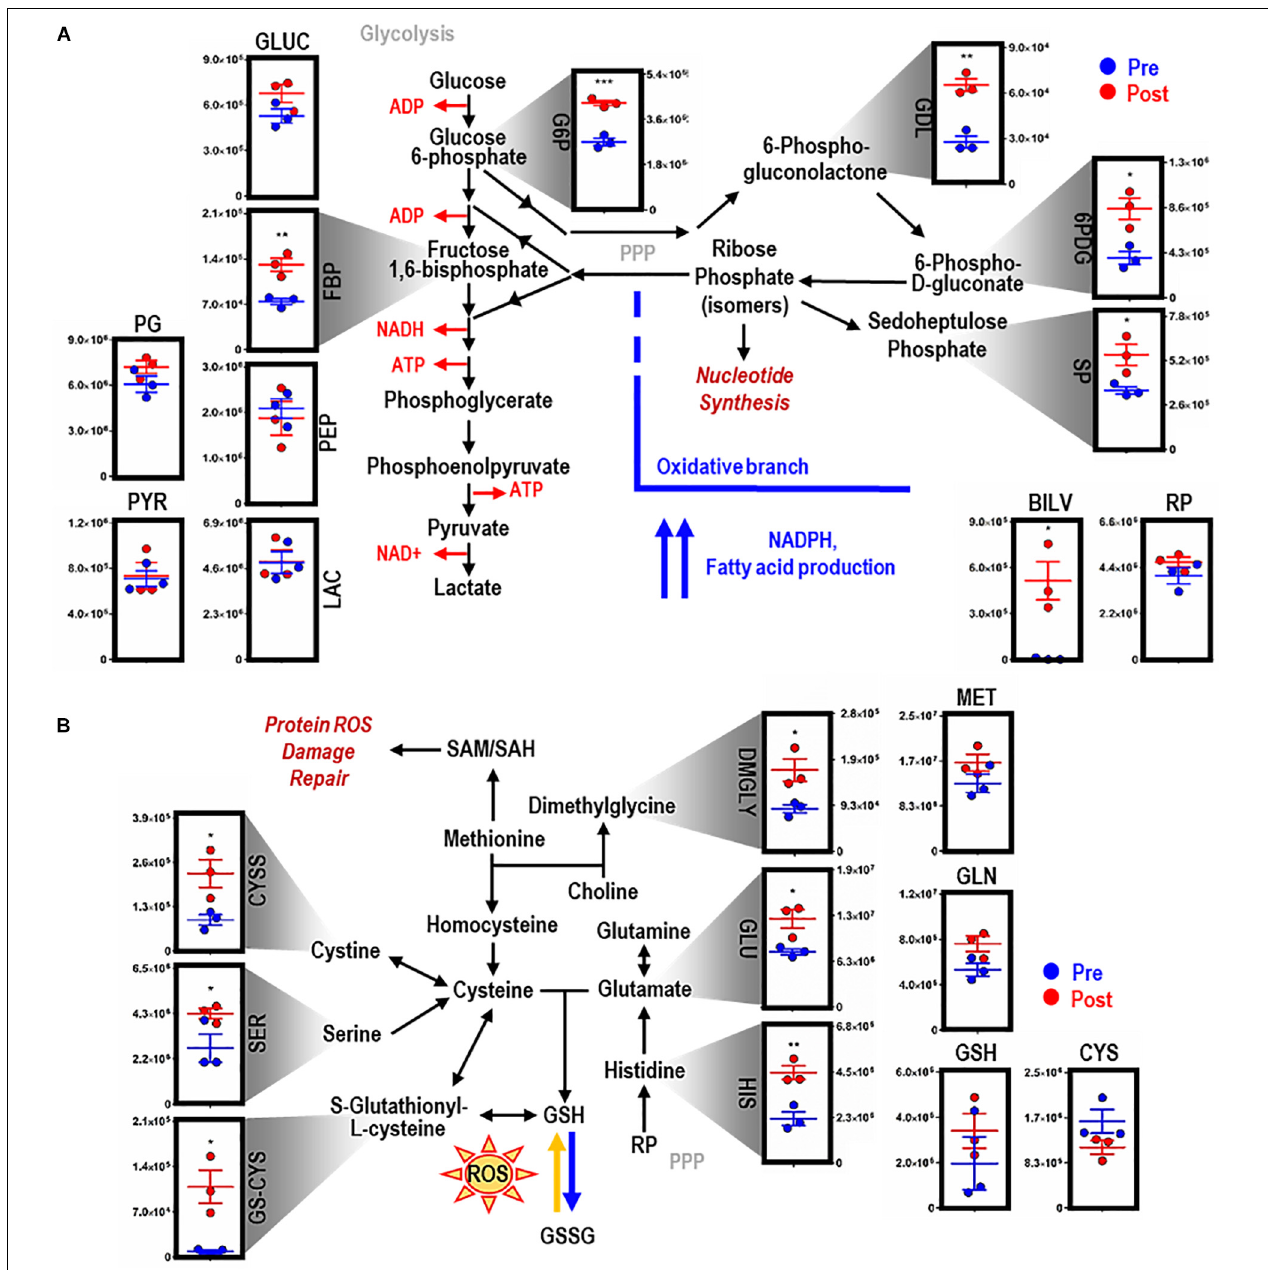
FIGURE 2 | EP reprograms glycolysis, the pentose phosphate pathway, and glutathione metabolism. Metabolites from glycolysis and the pentose phosphate pathway (PPP) (A) . As part of heme metabolism, biliverdin (BILV) confirms successful EP of IgG-opsonized RBCs by BMDMs. Entry into glutathione (GSH) metabolism via methionine (MET) and glutamate (GLU) (B) . For all plots, the y-axis represents relative intensity (a.u.). * p ≤ 0.05; ** p ≤ 0.01; *** p ≤ 0.001 (unpaired t -test, 2-tailed distribution). GLUC, glucose; G6P, glucose 6-phosphate; FBP, fructose bisphosphate; PG, phophoglycerate; PEP, phosphoenolpyruvate; PYR, pyruvate; LAC, lactate; GDL, 6-phosphate gluconolactone; 6PDG, 6-phospho-D-gluconate; SP, sedoheptulose phosphate; RP, ribose phosphate (isomers); GLN, glutamine; CYS, cysteine; CYSS, cystine; SER, serine; GS-CYS, S-gultathionyl-L-cysteine; HIS, histidine; DMGLY, dimethylglygine; SAM/H, S-adenosyl